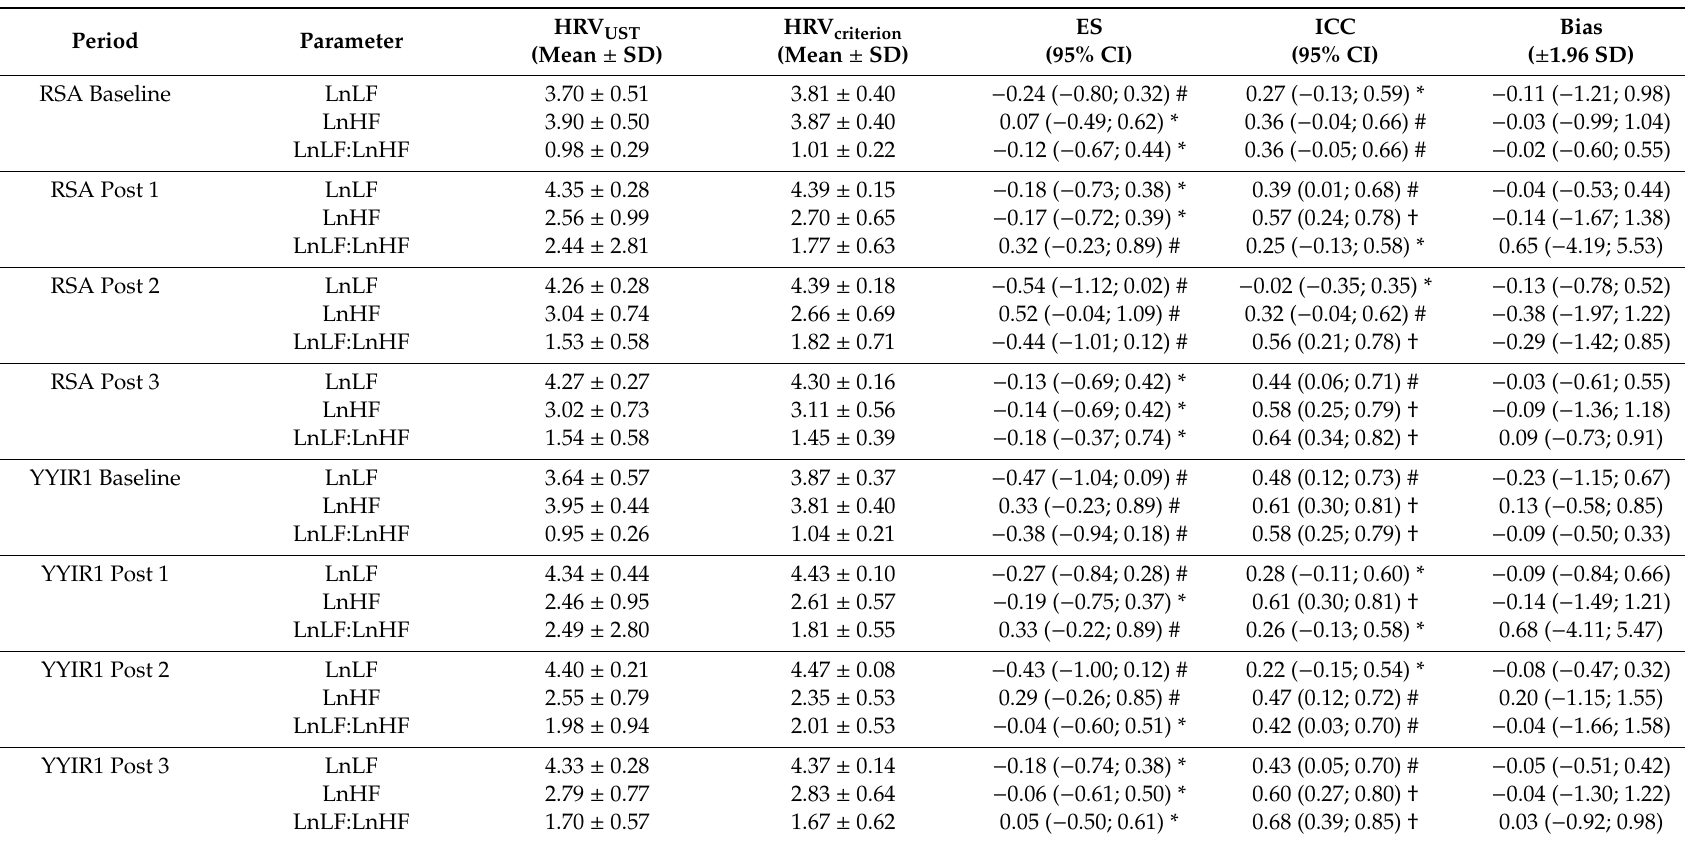
Table 3. Natural logarithm of low frequency power (LnLF), high frequency power (LnHF), and LnLF:LnHF ratio during 0–5 min of time segments of the baseline,